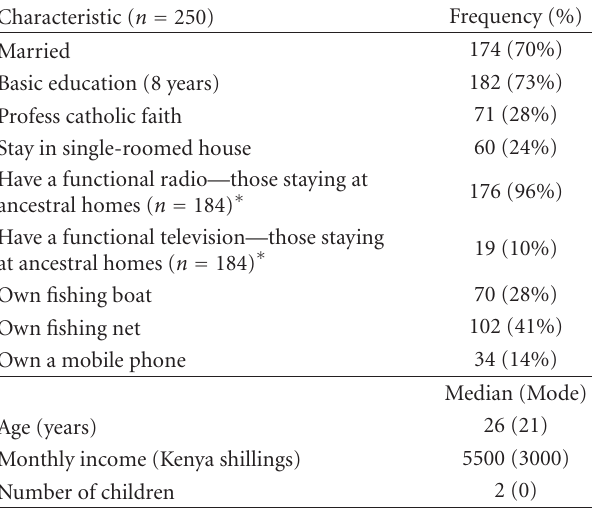
Table 1: Characteristics of 250 fishermen recruited in a preclinical survey to determine their suitability for a male microbicide